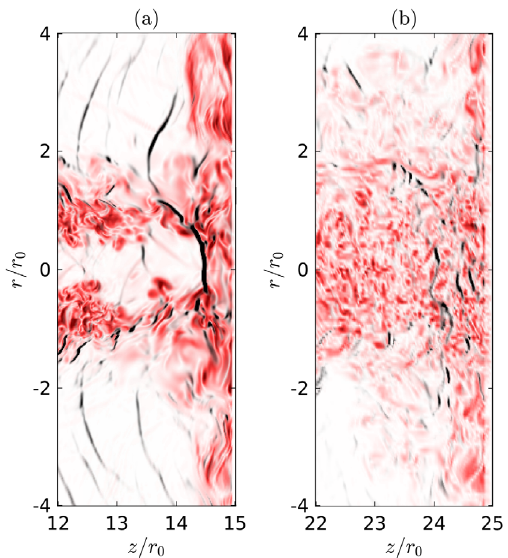
Figure 13. Fields of density gradient o q / o z (black) and vorticity (red) near the plate for (a) L = 15 r 0 and (b) L = 25 r 0 . The color scales range from 0 to 4 gradient, from white to black, and from 0 to 7.5 u e / r 0 for the vorticity, from white to